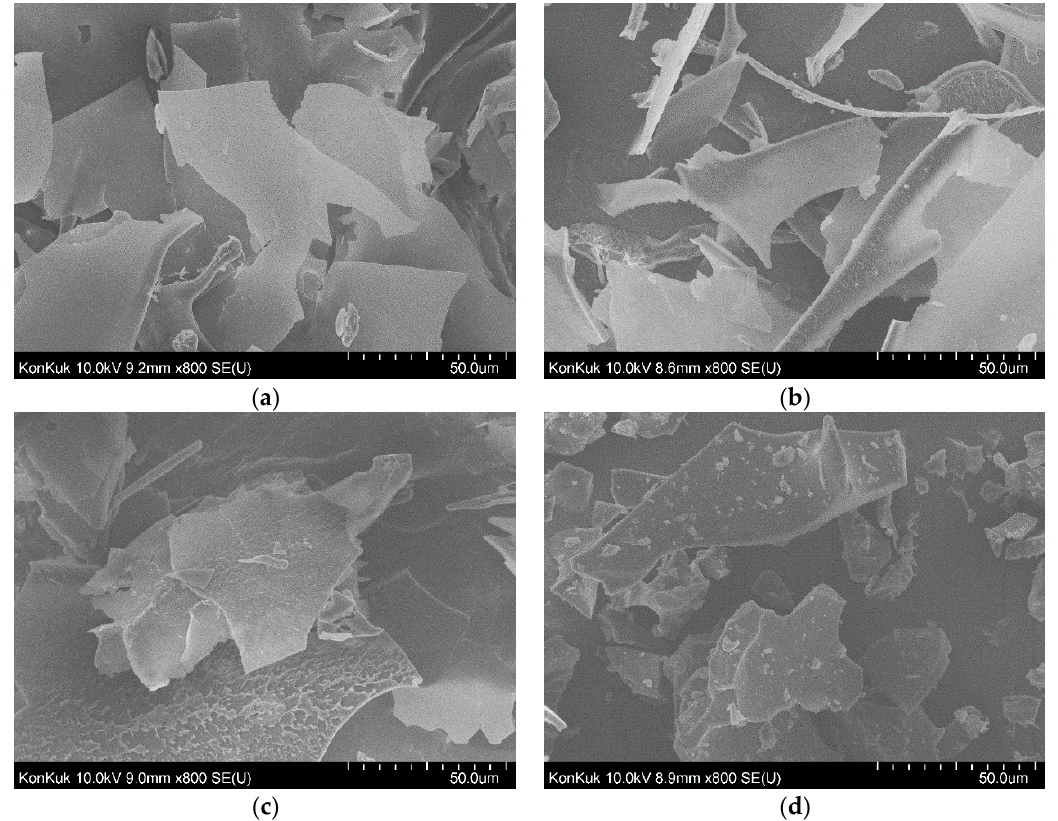
Figure 7. SEM images of ( a ) F1 fraction; ( b ) F2 fraction; ( c ) F3 fraction; ( d ) F4 fraction.